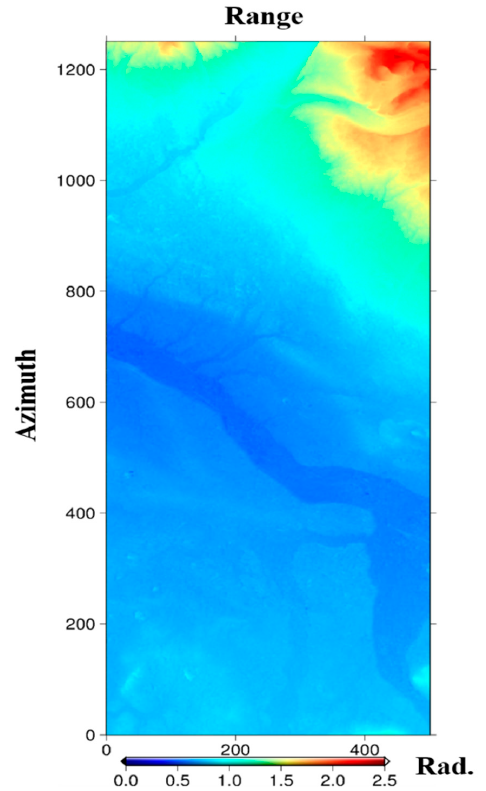
Figure 6. Simulated topographic phase used in this experiment. Appl. Sci. 2019 , 9 , x FOR PEER REVIEW